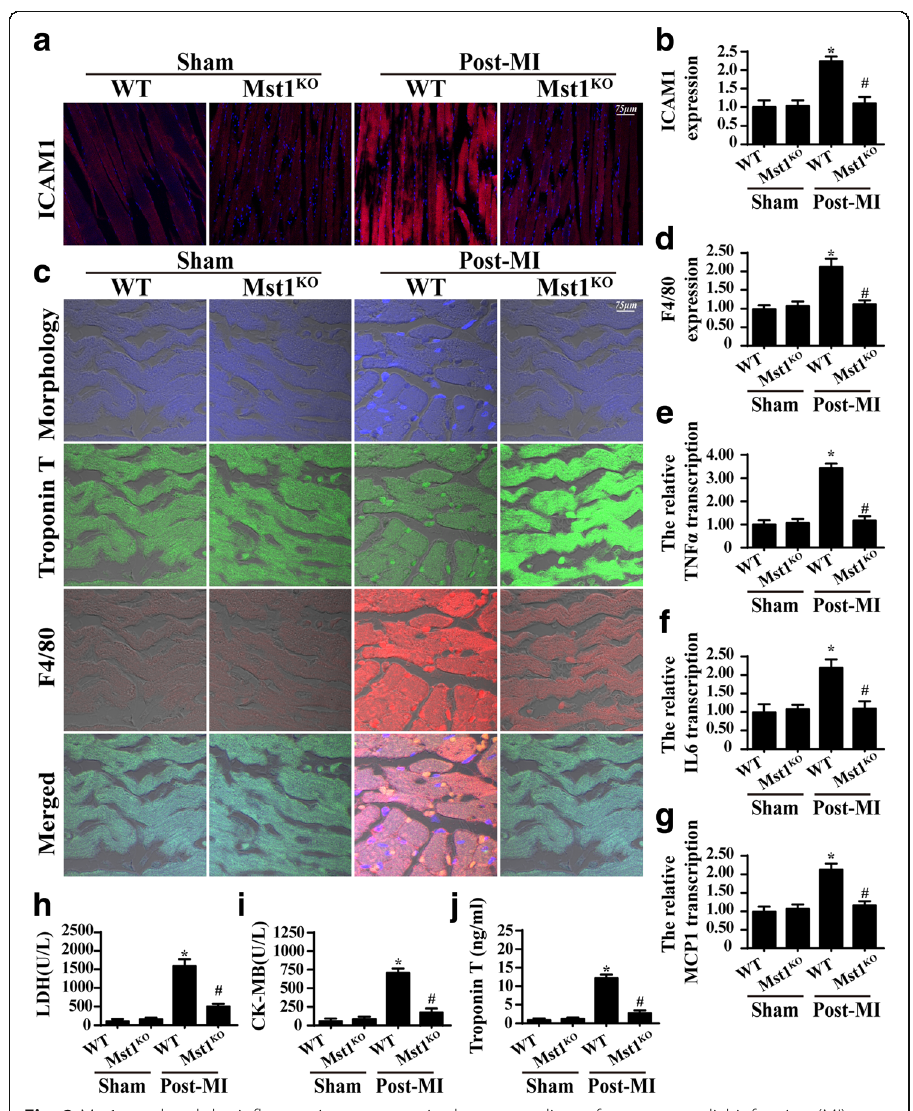
Fig. 2 Mst1 regulated the inflammation response in the myocardium after a myocardial infarction (MI). a and b The expression of ICAM1 in myocardial tissue. c and d F4/80-positive macrophage migration into myocardial tissue was observed in wild-type (WT) cells post-MI using immunofluorescence assay. e – g The transcriptional alterations of inflammation factors (TNF α , IL6 and MCP1) in the myocardium post-MI. h – j The cardiac damage markers LDH, CK-MB and troponin-T were assessed in WT and Mst1-knockout (Mst1 KO ) cells via ELISA. *p < 0.05 vs. sham group, # p < 0.05 vs. WT mice in post-MI